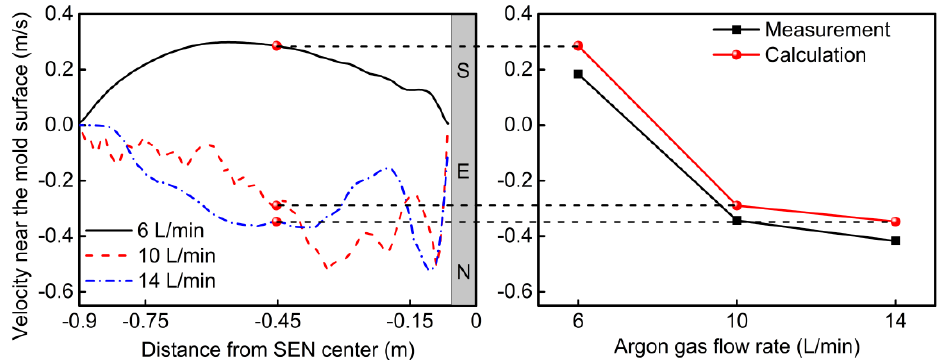
Figure 3. Comparison of the measured and calculated velocities near mold surface at the different argon gas flow rates. argon gas flow